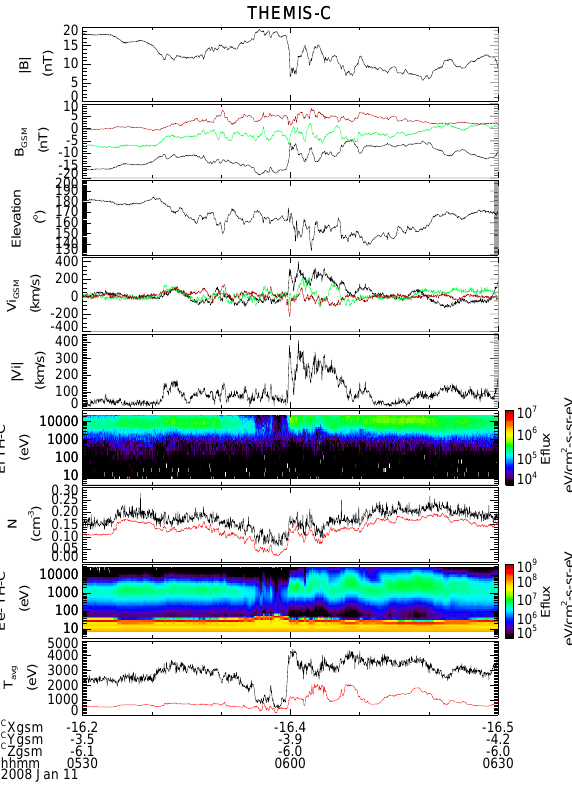
Fig. 5. Themis C observations in the same format and for the same time period as Fig. 2, except that the Rankin Inlet magnetometer data is not included.